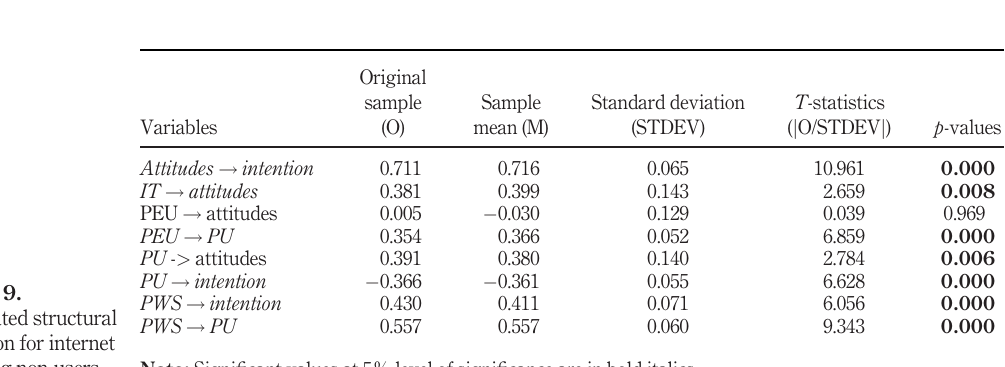
equation for internet banking users